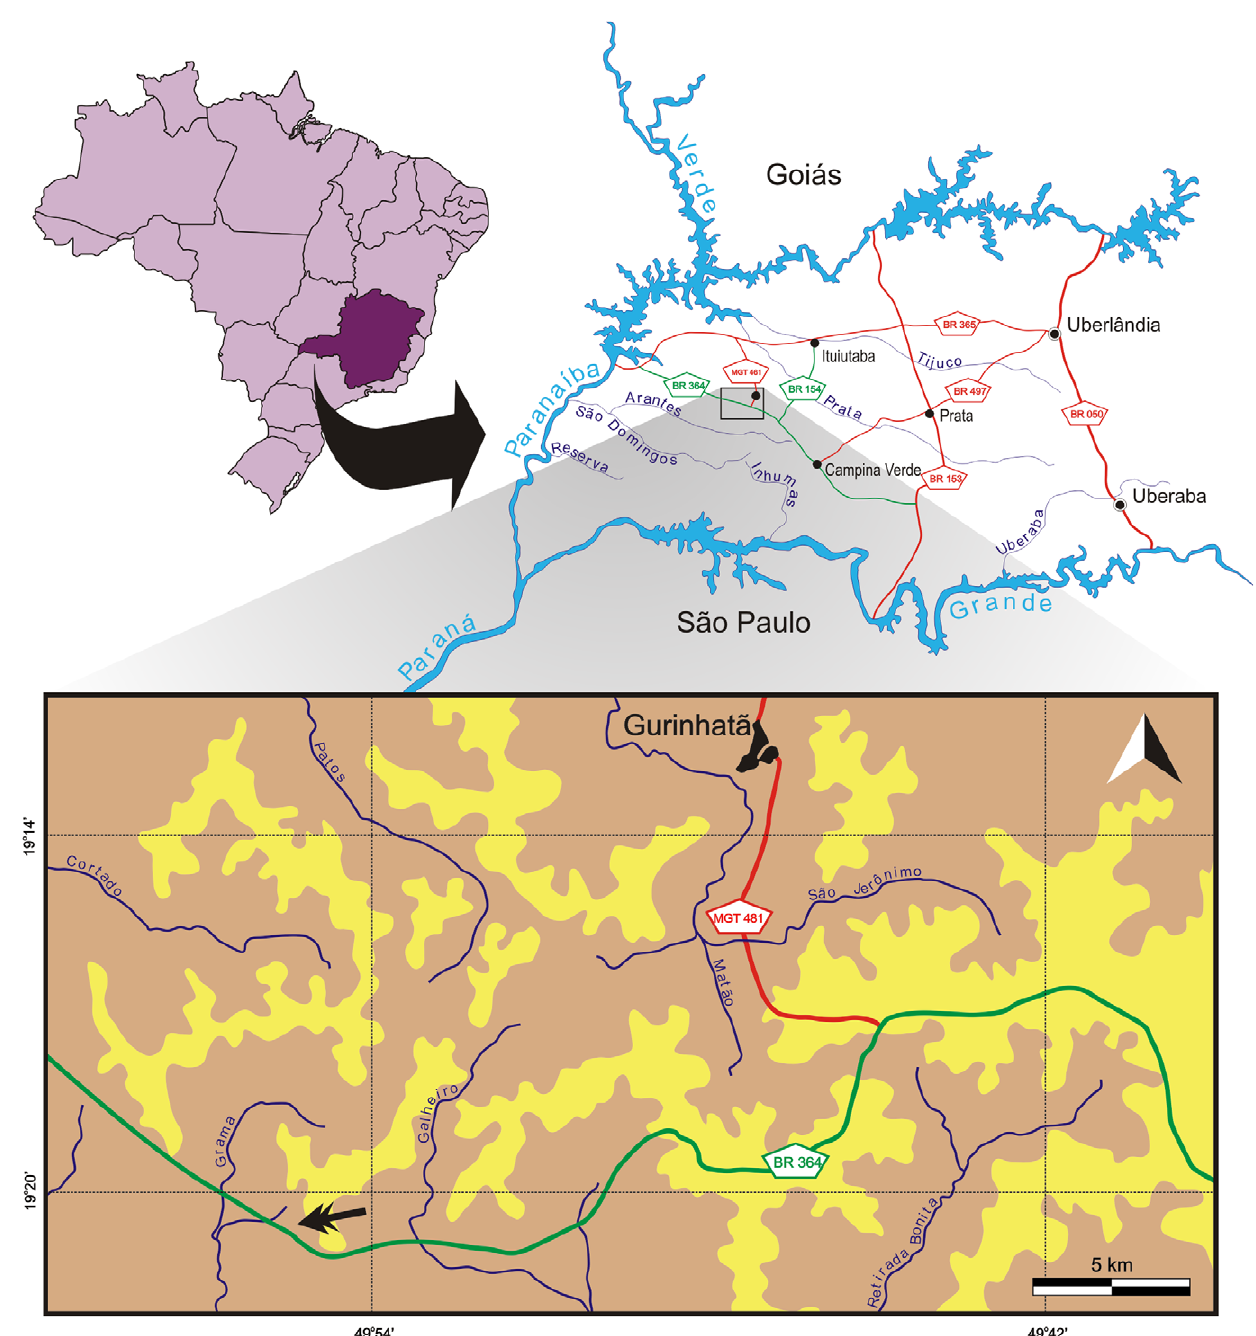
Figure 1. Map of the area where Pissarrachampsasera was collected. Area highlighted in maps of Brazil, Minas Gerais (above on the left), and the Triaˆngulo Mineiro region (above on the right). Main river courses indicated in blue, paved roads in red, and secondary non-paved roads in green. Surface distribution of the Bauru Group rocks based on [106]: beige = Vale do Rio do Peixe Formation; yellow = Marı´lia Formation.